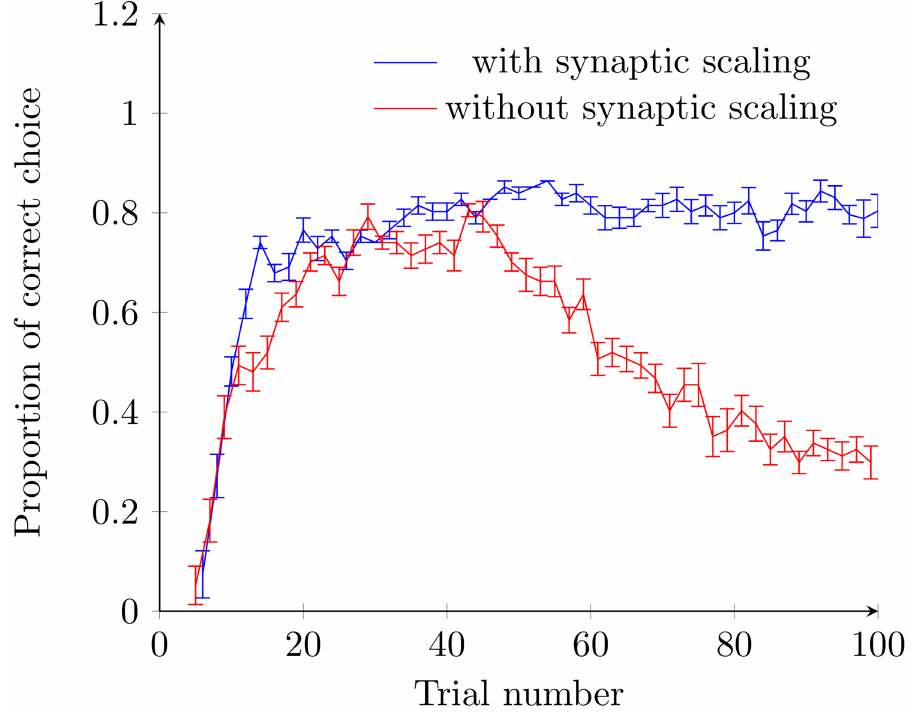
Fig 3. Proportion of correct choice versus trial number. In this case, cue C 2 is always appliedas the test cue. The blue curve shows the proportionof correct choices for the spikingneuralcircuit model with both STDP and synaptic scaling, whilst the red curve shows the neuralcircuit model without synapticscaling. The bars show the standard error of the mean. Initially, both models show similar behaviour, namely an initial proportionof correct choice rate which is very low. After continuedtraining, the accuracyof the model without synapticscaling then beginsto decrease. This decreaseis due to an increase in the proportionof neural circuits in which the propagatingwave pattern splits and travels along both arms of the T-maze. This decrease in accuracyis not observedin the full model, which maintainsaccuracy even as trainingcontinues.The final success rate of 80% is similar to that observed in experimental studies (75% in